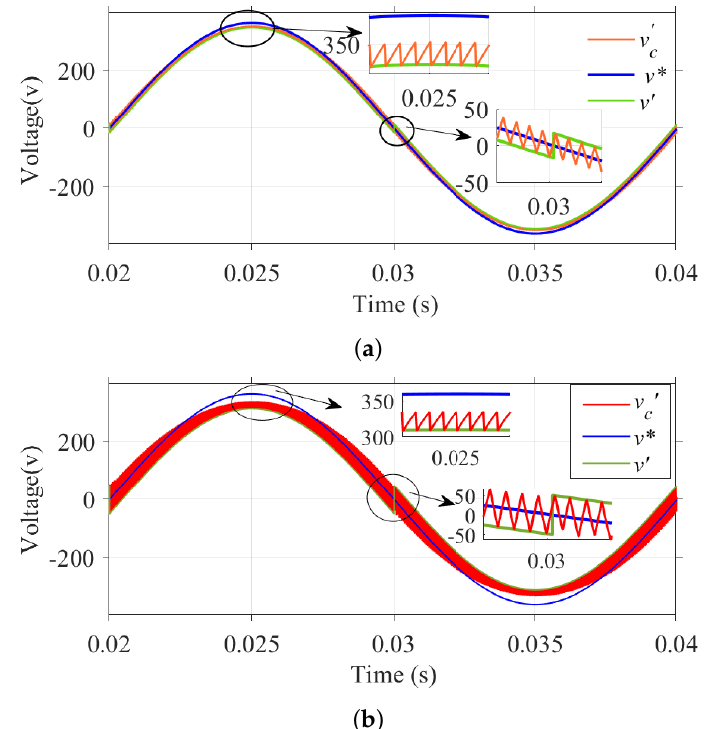
Figure 11. Fixed offset correction: Simulated waveforms of v c (cid:48) , v ∗ , and v (cid:48) for different cut-off frequencies. ( a ) f c = 0.5 kHz; ( b ) f c = 1.5 kHz.